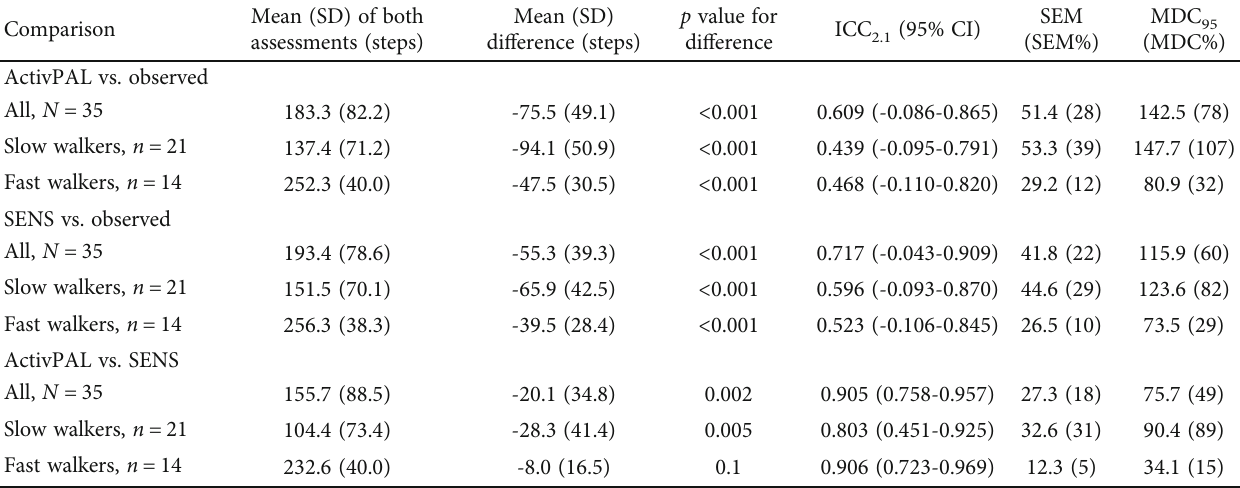
Table 5: Relative and absolute reliability of steps, assessed with ActivPAL3 ™ , SENS motion®, and direct observations. Mean (SD) of both Comparison ActivPAL vs.